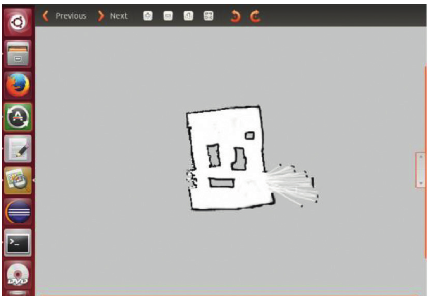
Figure 4: Environment map.